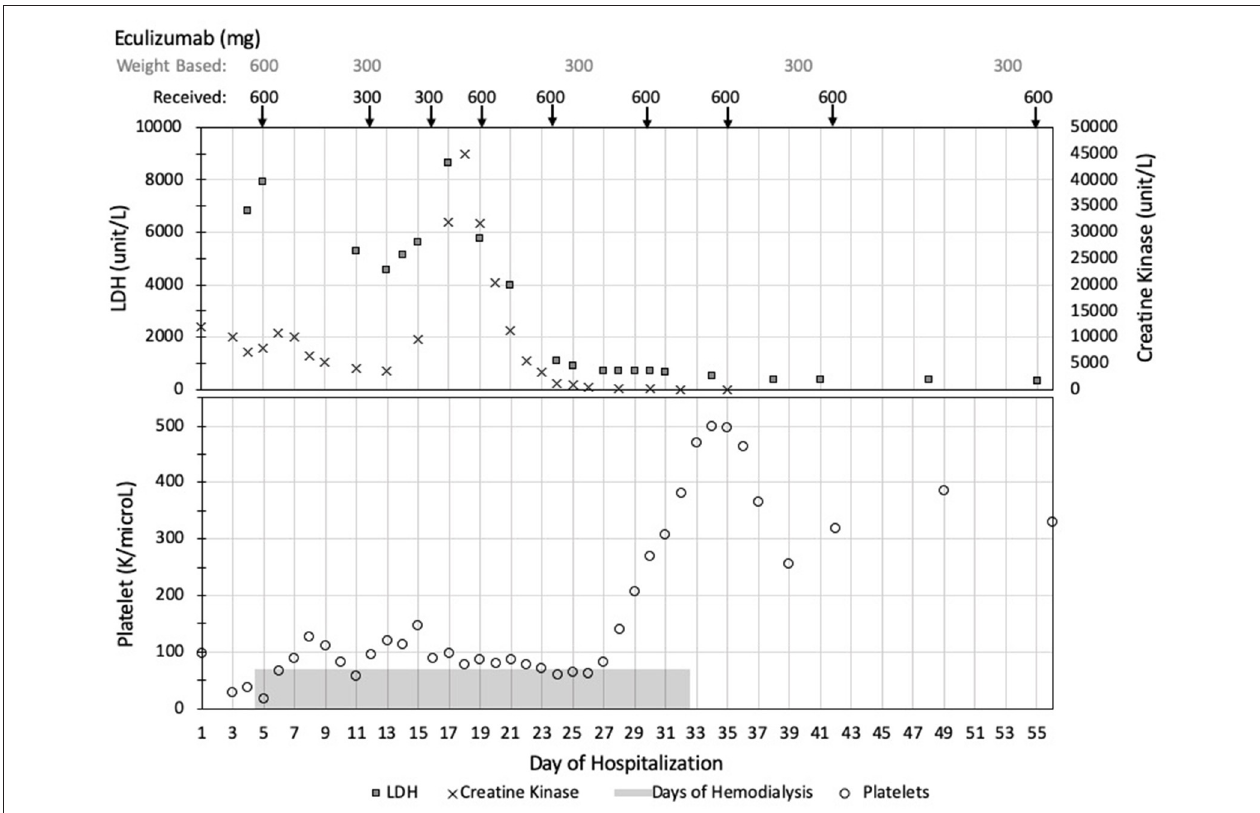
FIGURE 2 | Summary of clinical values and eculizumab dosing. Data is presented in chronological order with days of hospitalization listed across the bottom of the figure. Eculizumab dosing started on day of hospitalization 4. The weight-based recommended dosing of eculizumab is listed across the top of the figure with the actual doses received reported directly below. TMA activity is demonstrated with elevated LDH (squares) and low platelets (circles). In his unique case, his rhabdomyolysis, as demonstrated by elevated CK levels (crosses), paralleled his TMA activity. TMA, thrombotic microangiopathy; LDH, lactate dehydrogenase; CK, creatine kinase.